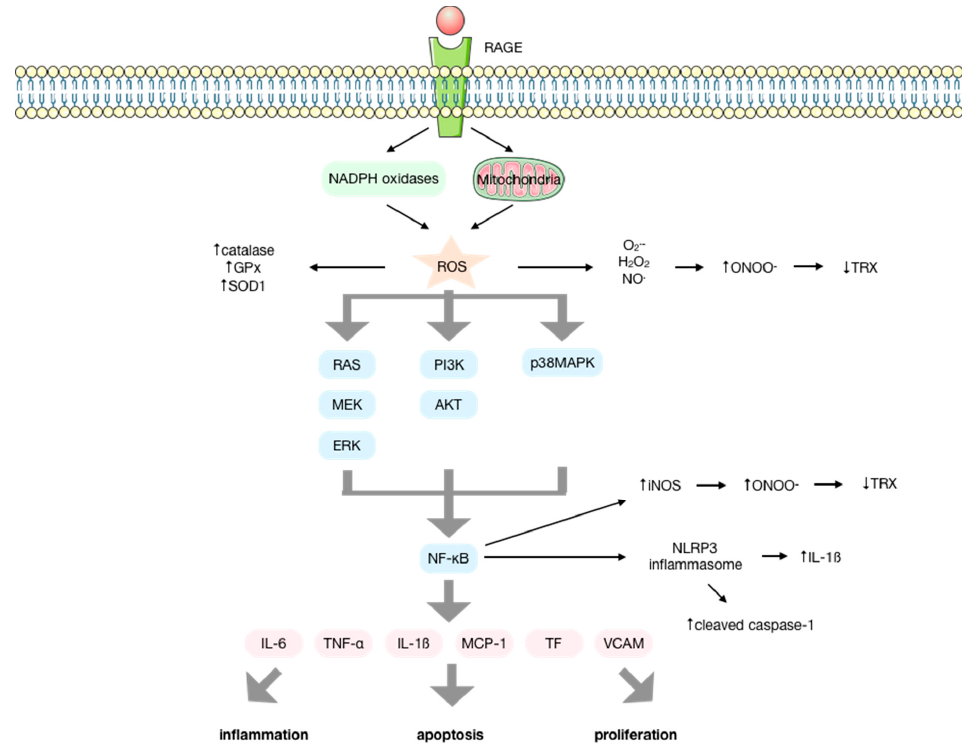
Figure 2. Molecular signaling pathways activated upon the interaction of advanced glycation endproducts (AGEs) with their receptor (RAGE). AGEs interact with their receptor RAGE, increasing the production of ROS by the NOX enzymes and the mitochondria, enhancing the activity of antioxidant enzymes. ROS initiate several signal transduction cascades such as RAS / MEK / ERK, IP3K / AKT or p38MAPK that lead to the activation of NF- κ B that results in the activation of the NLRP-3 inflammasome and the production of several cytokines, chemokines, and other proinflammatory factors, inducing inflammation, apoptosis, and proliferation. The elevated production of O 2 − and NO mediated by AGEs and the upregulation of iNOS by NF- κ B favor the production of ONOO − that conducts the inactivation of proteins such as thioredoxin, impeding its anti-apoptotic and antioxidant functions. AGE-RAGE interaction also results in an increased mRNA for heme oxygenase-1; it enhances the and generates ROS by other mechanisms